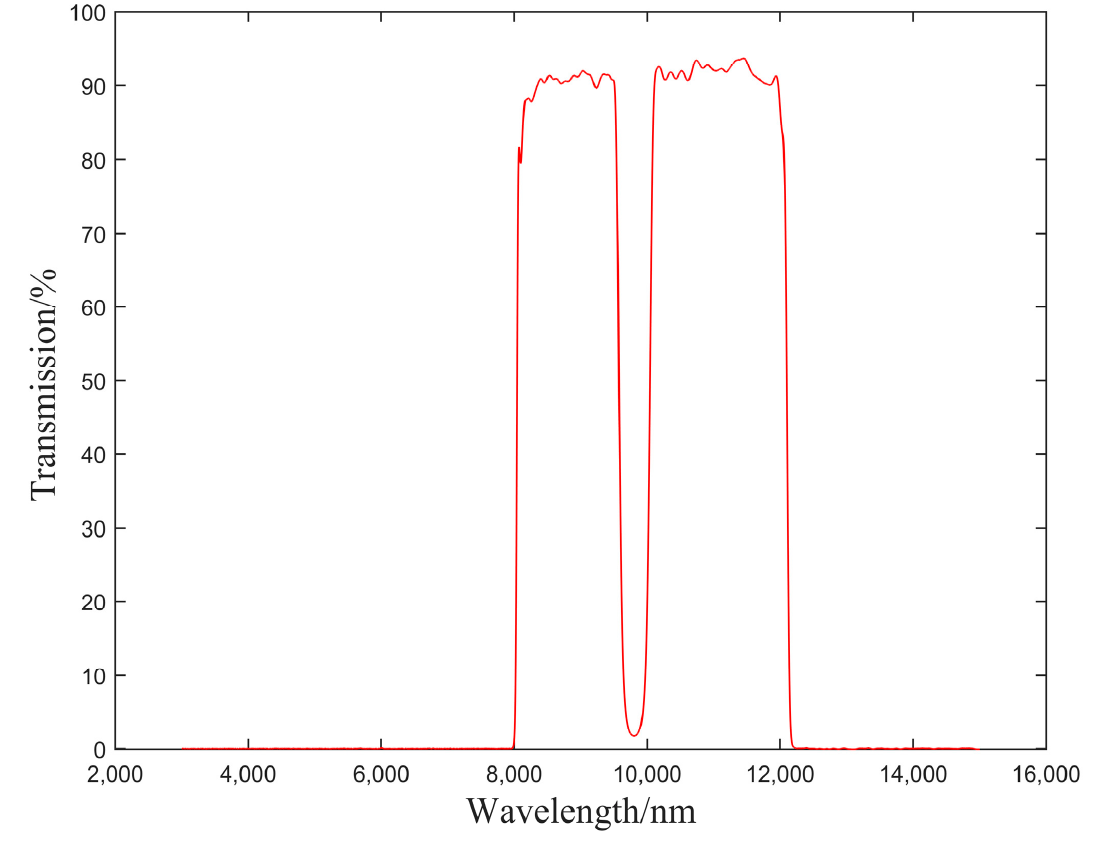
Figure 13. Transmittance curve of atmospheric transmittance equivalent analog filter.